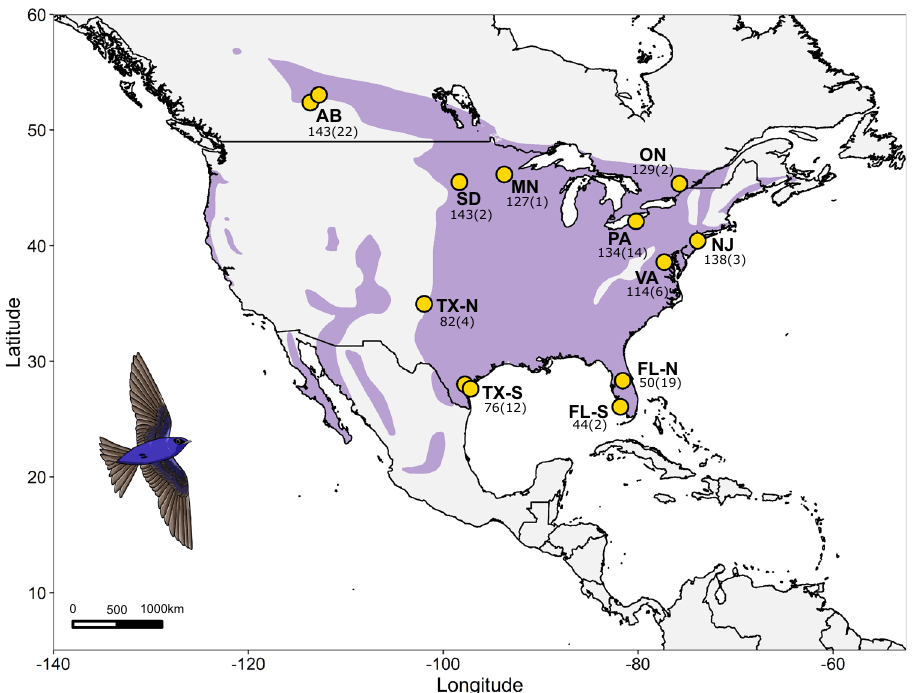
Figure 1. Purple martin breeding distribution (purple), including sampling sites for 87 individuals in their North American breeding range (yellow). The mean arrival date for each site is in ordinal date format (day of year), with the site sample size provided in parentheses. The purple martin range map layer was obtained through the IUCN red list